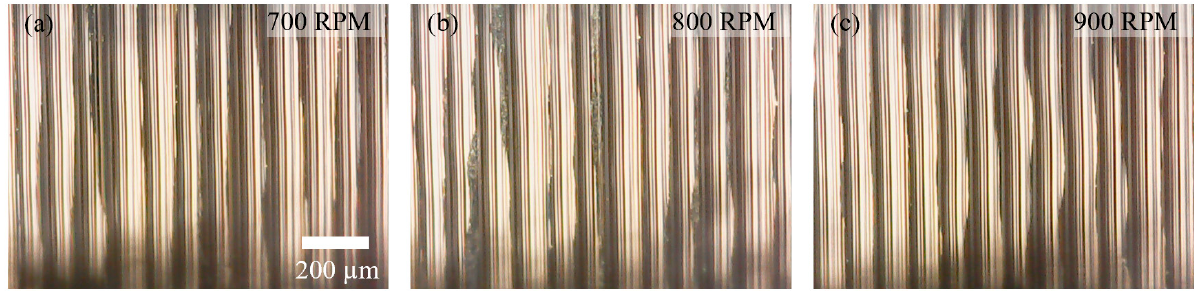
Figure 8. Microscope image of machined surface: ( a ) 700 rpm, ( b ) 800 rpm, and ( c ) 900 rpm.